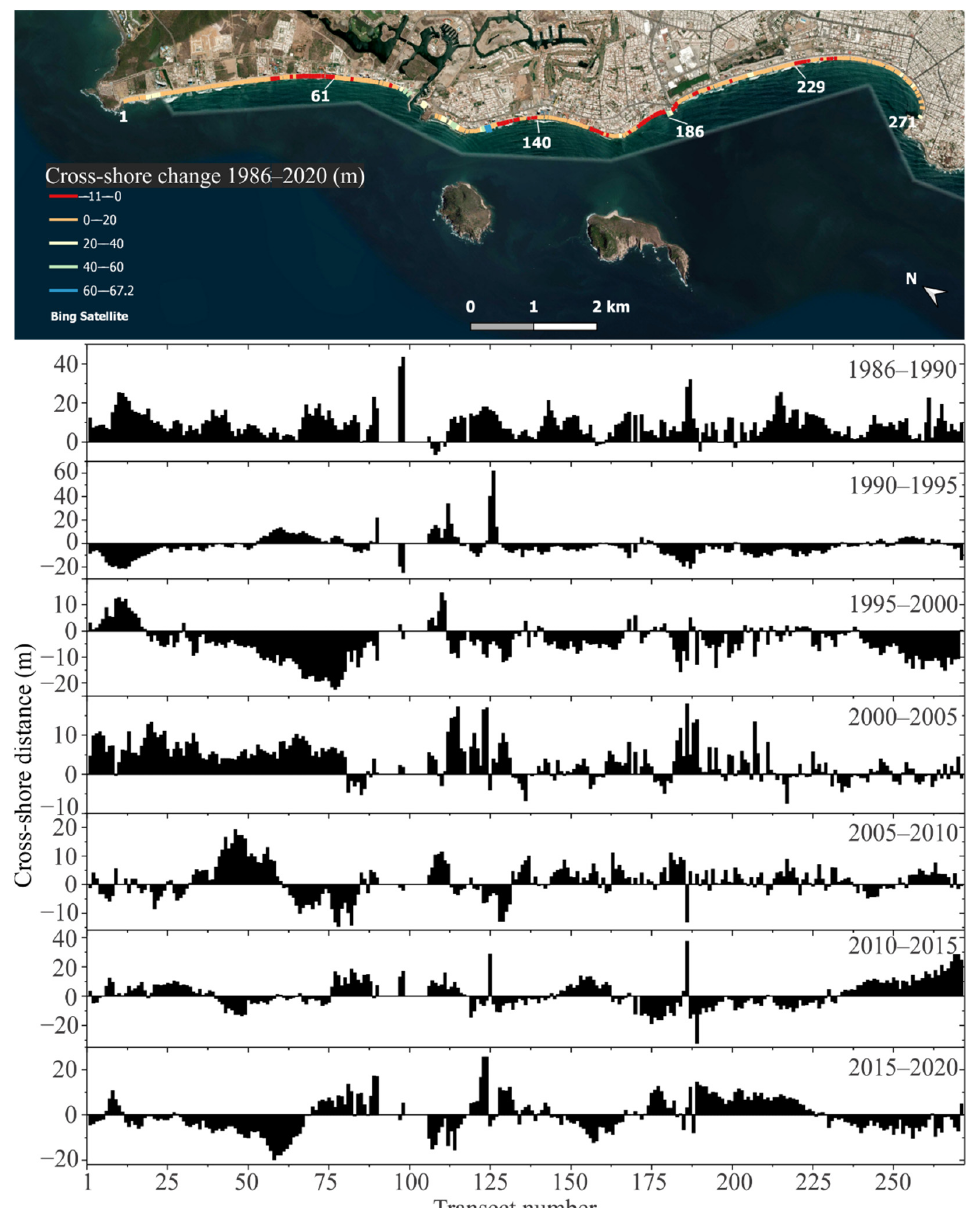
Figure 5. Across-shore distance change (1986–2020) along the coastline’s northern section of the study site ( top ). Specific accretion and erosion sections among the seven periods based on the CoastSat and DSAS analyses ( bottom ). Positive values represent accretion, while negative values indicate erosion.